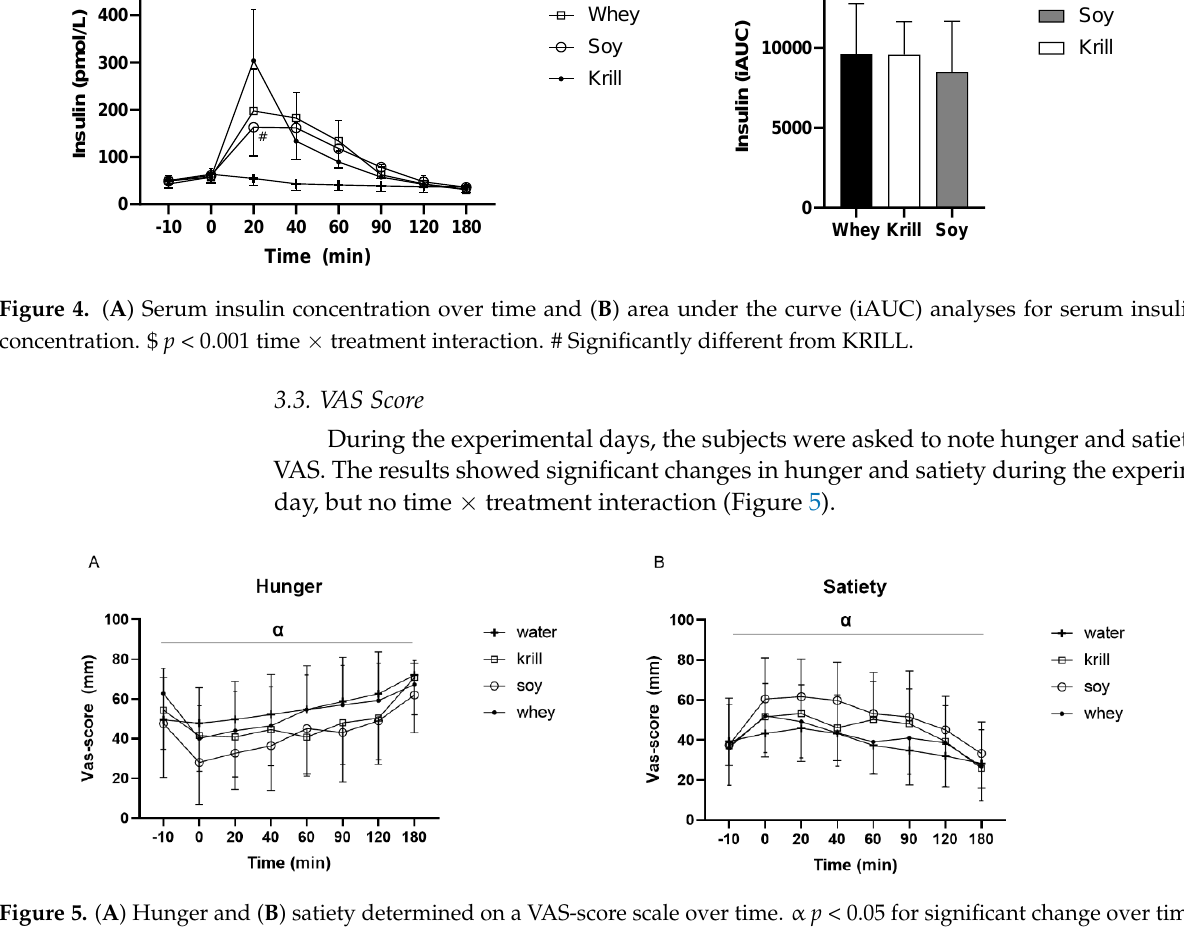
Figure 5. ( A ) Hunger and ( B ) satiety determined on a VAS-score scale over time. α p < 0.05 for significant change over time. No significant (NS) time × treatment interaction.